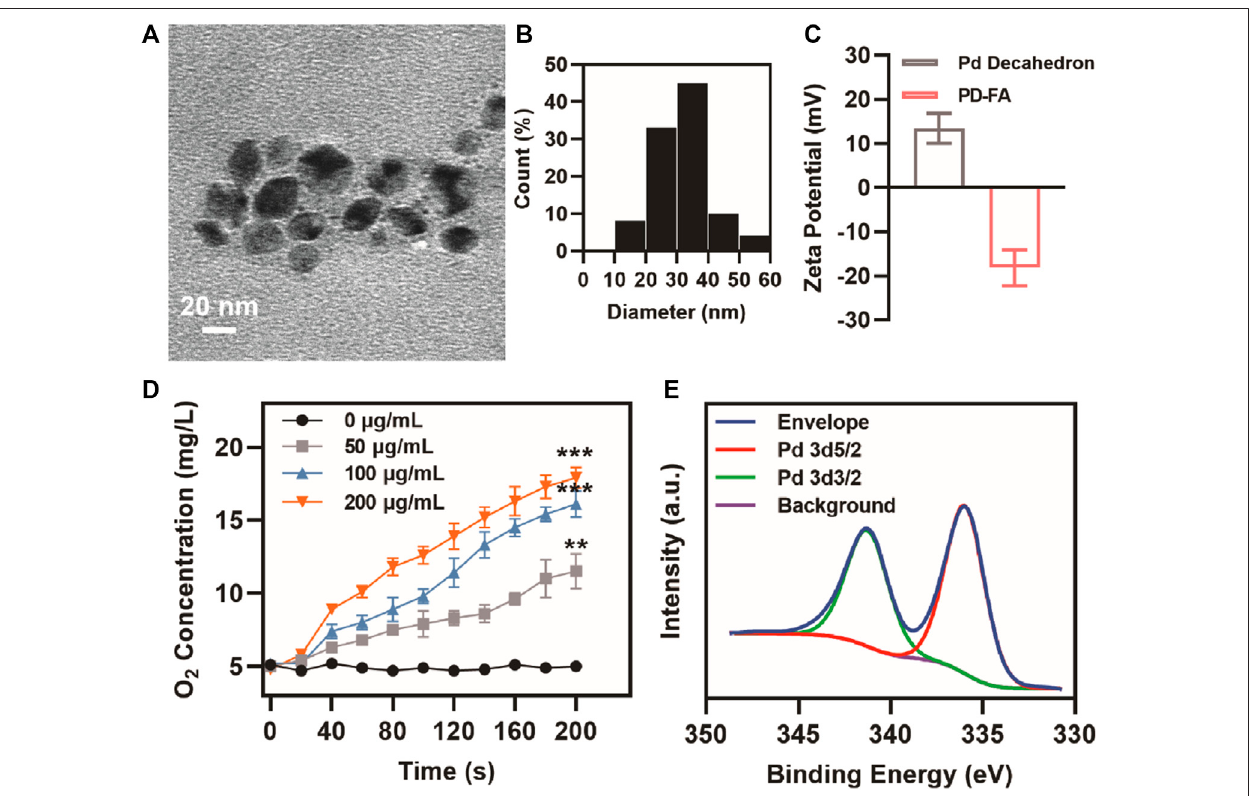
FIGURE 1 | PD-FA characterization. (A) TEM images of PD-FA and (B) PD-FA size distributions. (C) Zeta potential values for Pd decahedra and PD-FA preparations. (D) Oxygen content measurements following the addition of H 2 O 2 to PD-FA samples at the indicated concentrations. (E) XPS spectra corresponding to elemental